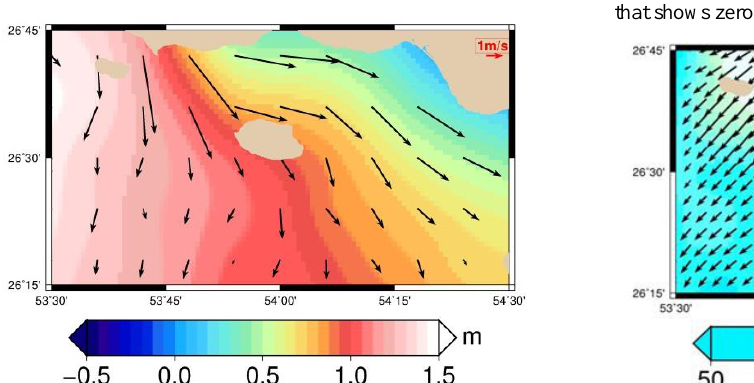
Figure 8. FSCs plotted on GCs